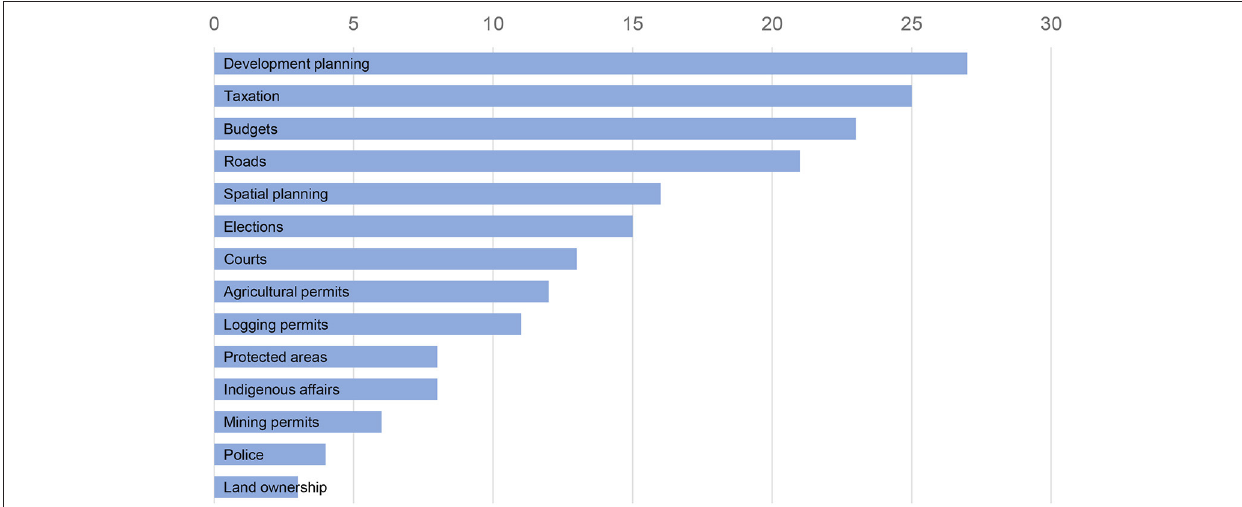
FIGURE 3 | Number of second-tier governments (out of 30) holding each authority.